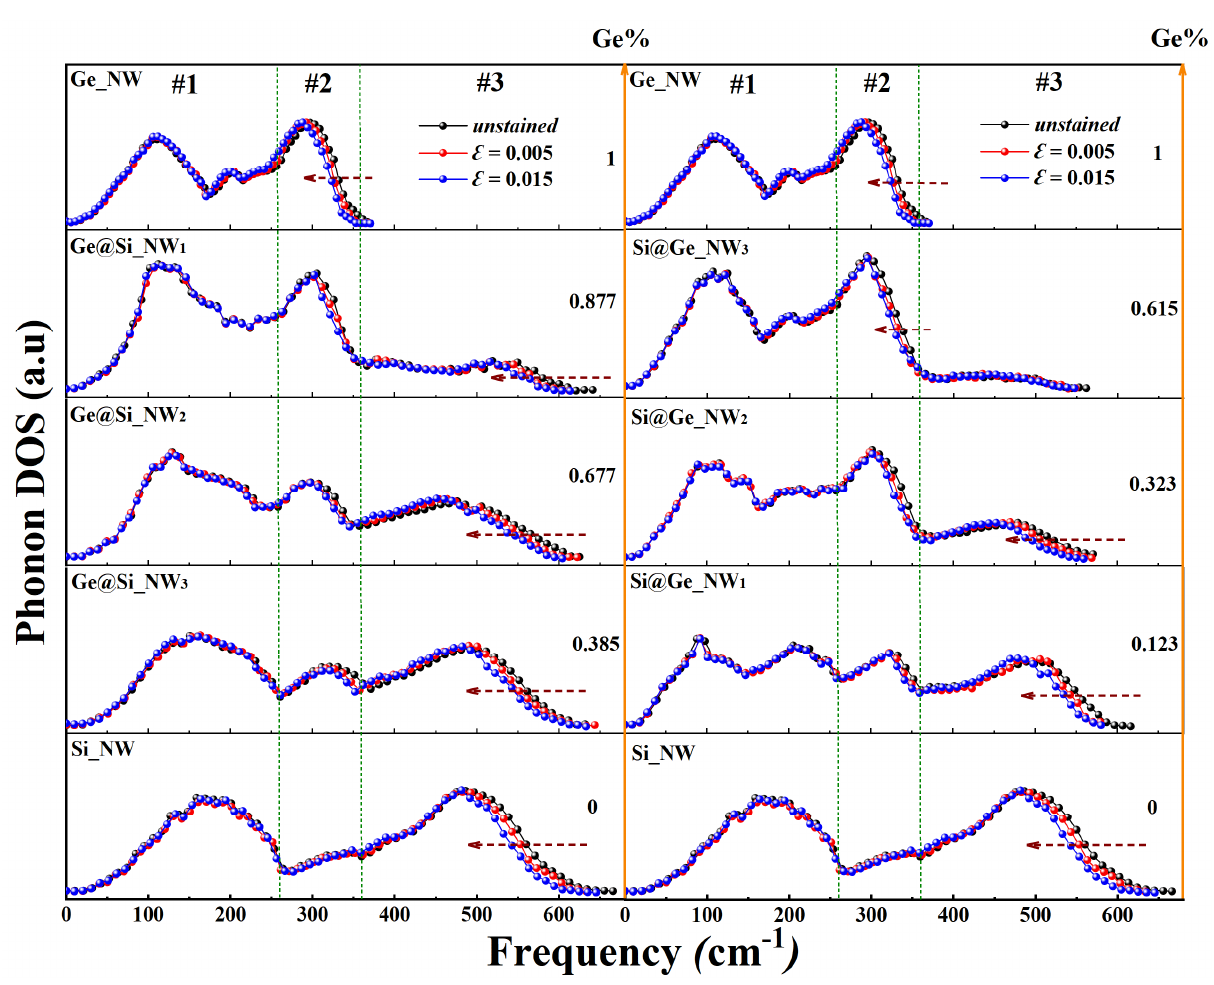
Figure 8. Phonon density of state (PDOS) for Ge@Si and Si@Ge nanowires with different core–shell ratios at 300 K.